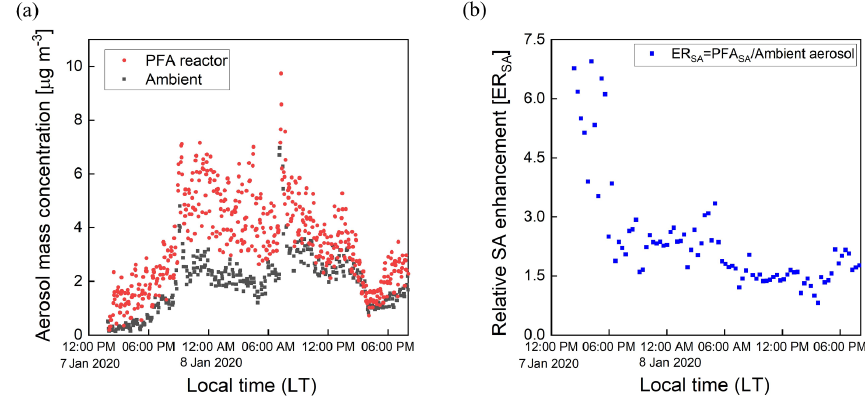
Figure 12. Time series of mass concentrations of the aerosol exiting the PFA OFR and that bypassing it (a) , and (b) the relative enhancement of the mass concentration due to SA